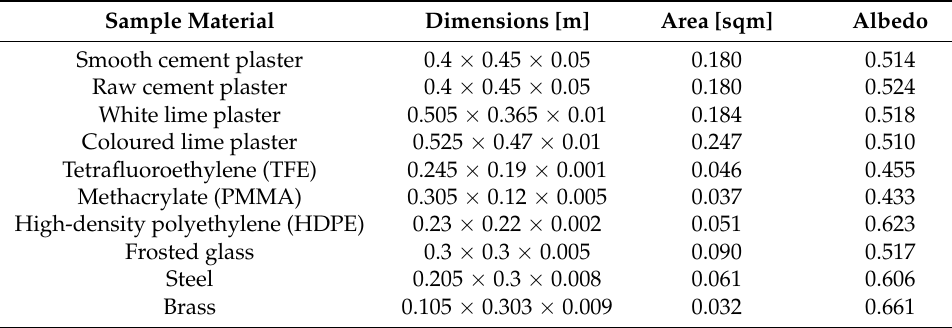
Table 2. Features of the material samples